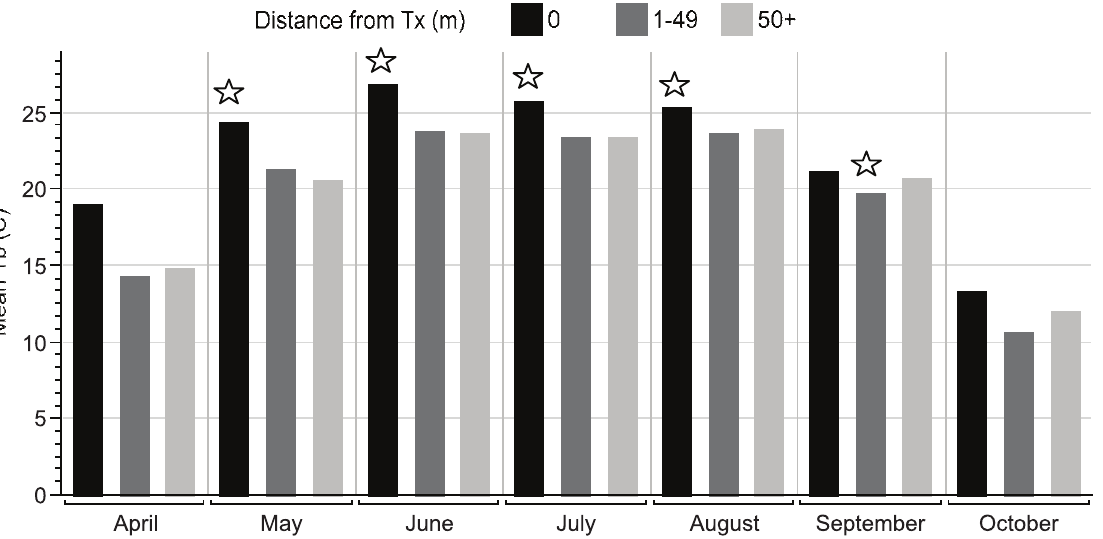
Figure 5. Harvest Proximity Temperatures. Mean eastern box turtle body temperatures (Tb) in degrees Celsius (C) with relation to timber harvest proximity over the active season months for post-harvest years (2009–10 combined). Starred bars represent significantly different mean temperatures during that month.